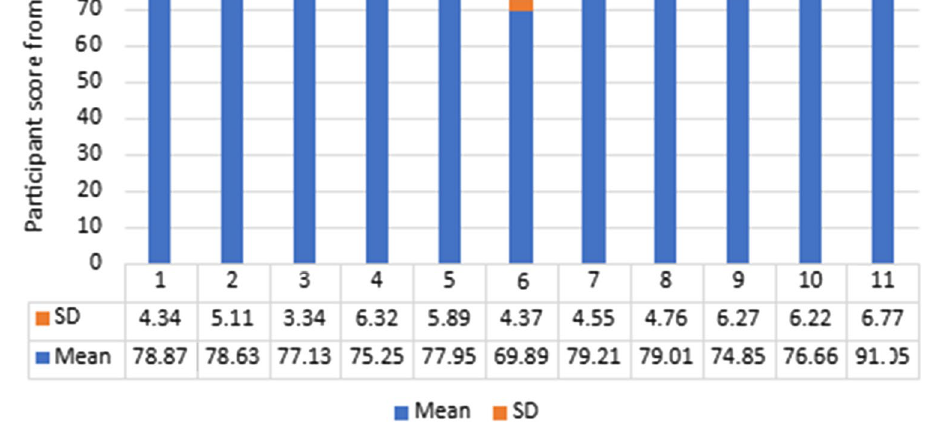
Fig. 2 Job candidate evalu- ation scores of 10 recruiters and AI recruiter (11) using real-time big data